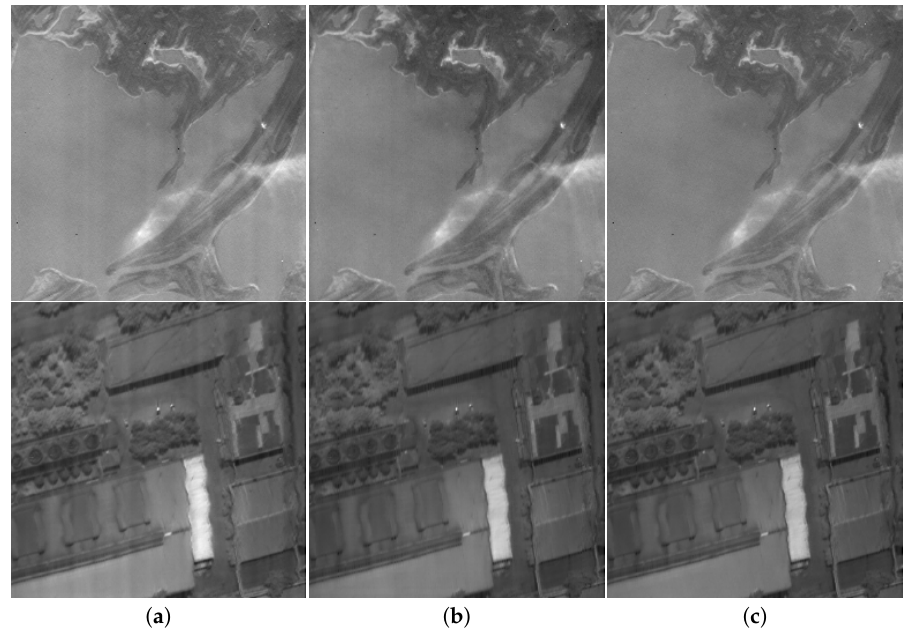
Figure 15. The images corrected with different models. Band 1 of the CHRIS_AM image and band 264 of the SWIR image are displayed sequentially from top to bottom. Corrected images obtained by ( a ) SCM, ( b ) CCM, ( c ) CSCNet.